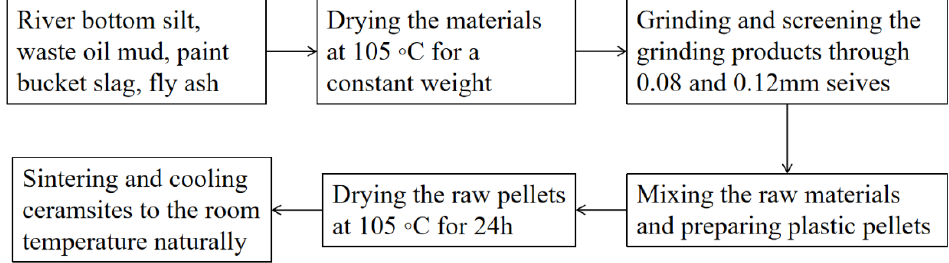
Figure 2. Flowchart of the preparation of solid waste ceramsite.